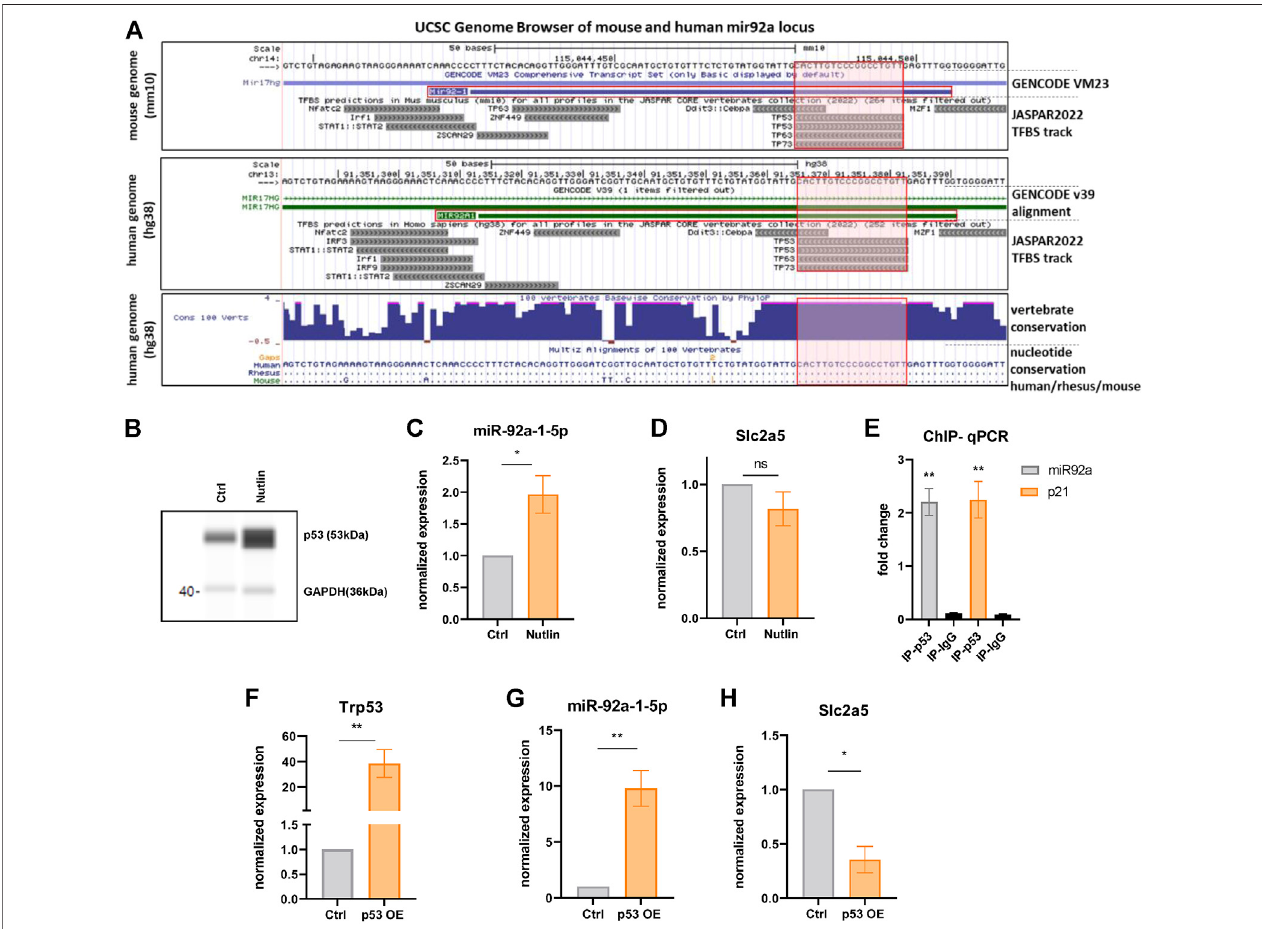
FIGURE 6 | p53 binds and activates the miR-92a-1-5p locus. (A) Excerpt from the UCSC genome browser tracks from mouse (mm10) and human (hg38) genomesinthevicinityofthemir92alocus(Mir92-1formousechromosome14,MIR92A1forhumanchromosome13).RespectiveJASPARtracksillustratep53binding motives(redshaded boxes)thatarefullyconservedbetweenhuman,rhesusmonkey,andmice(lowestbox;dotsdepictsequenceidentity). (B) WESdigitalwesternblot of p53 protein of iBACs after nutlin or vehicle treatment. GAPDH served as a loading control. (C) miR-92a-1-5p and (D) Slc2a5 expression after nutlin or vehicle treatmentofiBACs. (E) Fold-enrichmentofap53-bindingsiteatthemiR-92a-1-5plocus.ChIP-qPCRwasusedtoamplifychromatinderivedfromimmunoprecipitations with anti-p53 antibody or anti-IgG antibody. A known p53 binding site in the Cdkn1a locus served as positive control and primer pairs targeting distant loci without predicted p53 binding sites served as negative control. (F) mRNA expression of Trp53 upon overexpression of full length wild-type p53 (or transfection with empty control vector) in iBACs. Expression of (G) miR-92a-1-5p and (H) Slc2a5 upon overexpression of p53 or control in iBACs. Data are presented as mean values ± SEM. Signi fi cances were determined by unpaired Student ’ s t-tests. Differences not indicated with asterisks or indicated with ns are not statistically signi fi cant ( p > 0.05). * p < 0.05, and ** p < 0.01.